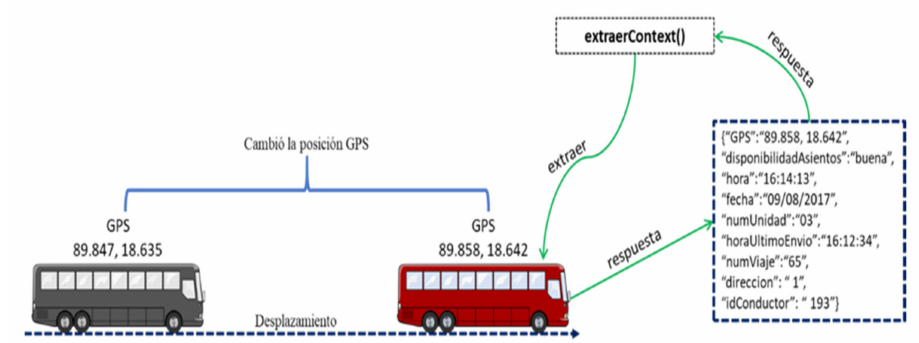
Figure 7. Context data produced by a bus on the route.